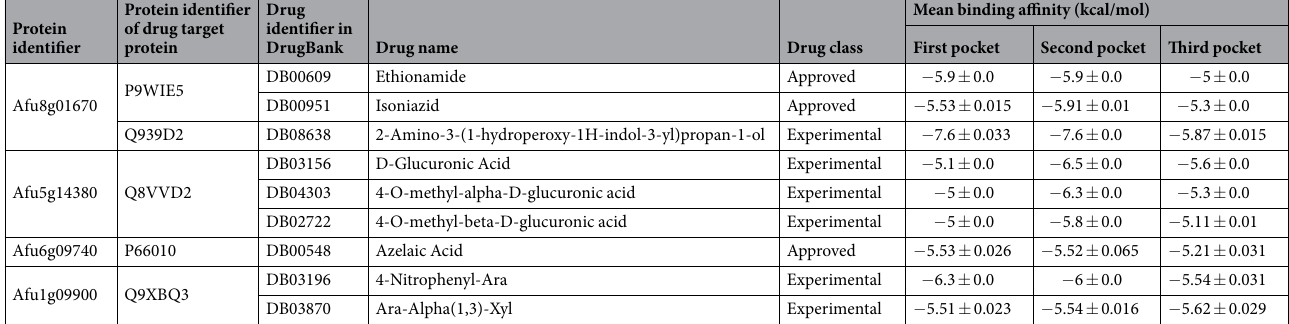
Table 2. Binding affinity of potential drugs against predicted pockets of the four candidate proteins in Aspergillus fumigatus . Note that the drug candidates were identified based on sequence and structural similarity of the four upregulated proteins in A. fumigatus with known drug target proteins in DrugBank 25 database. The ligand binding pockets were predicted using metaPocket 2.0 117 webserver and binding affinities of drugs to proteins were computed using AutoDock Vina 118